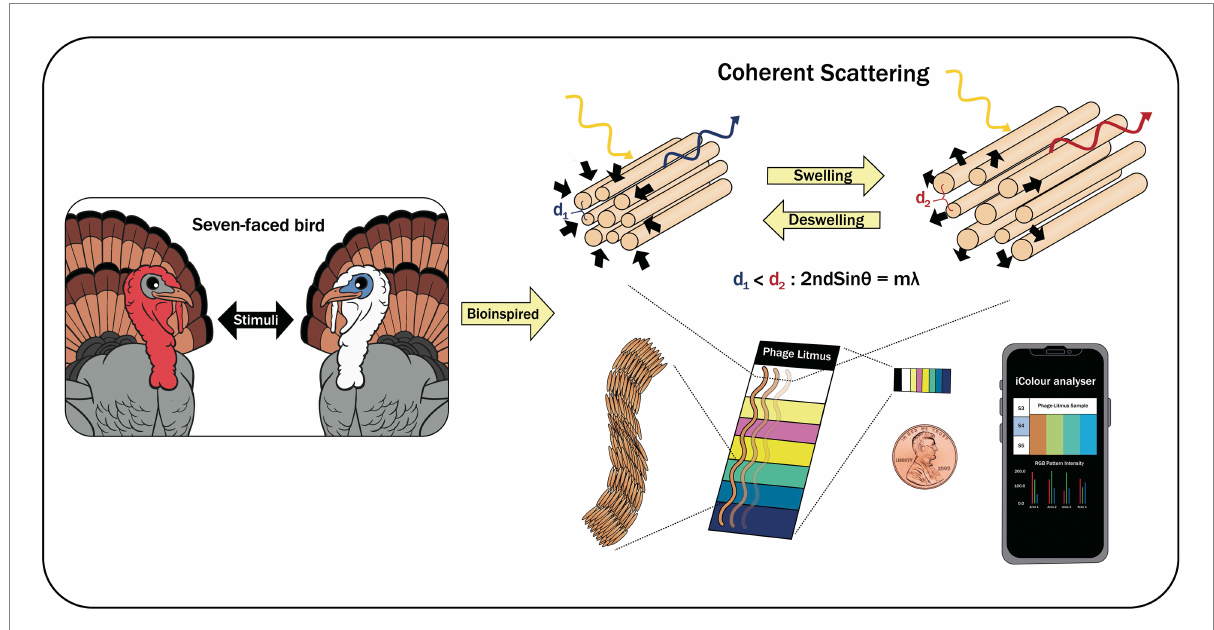
FIGURE 5 A biomimetic-based biosensor with Phage Litmus similar to collagen structures in turkey skin (Oh et al.,